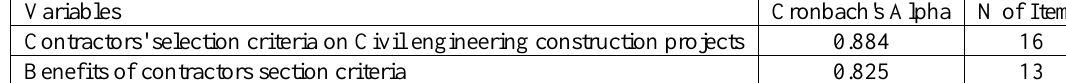
Table 3: Reliability Statistics.